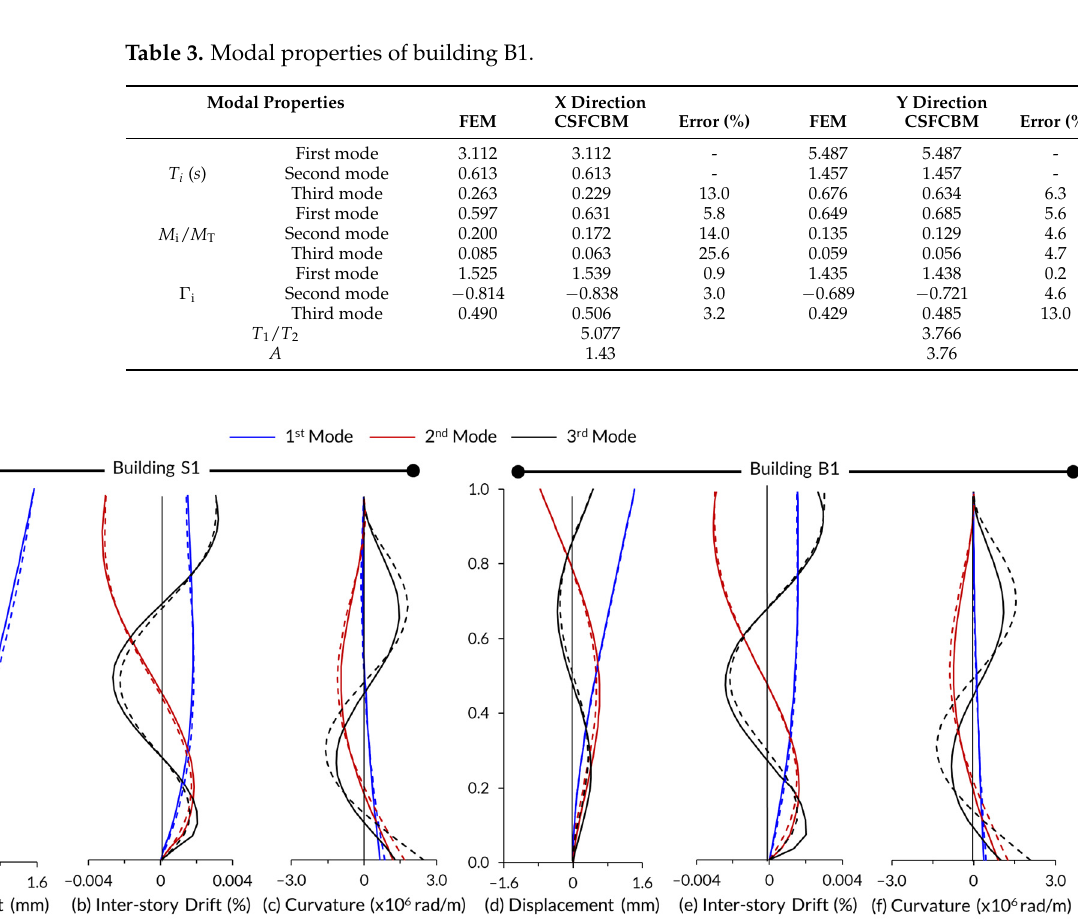
Figure 5. Force responses of building S1 in the x direction. Figure 6. Force responses of building B1 in the x direction.